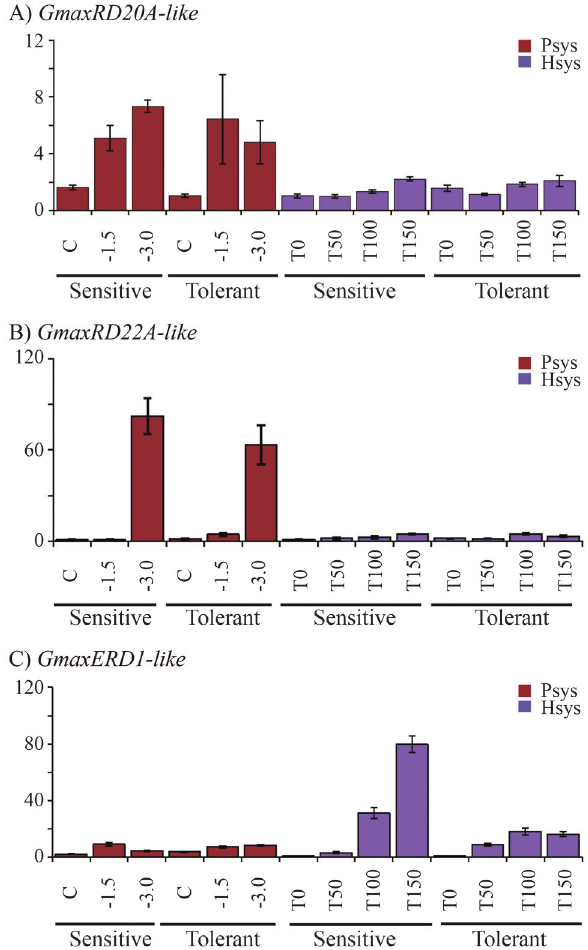
Figure 2 - Expression profile analyses for the soybean genes GmaxRD20A- like (A), GmaxRD22- like (B) and GmaxERD1- like (C) in the roots of sensitive and tolerant cultivars during water deficit stress in pot-based (PSys) and hydroponic (HSys) systems. Marker genes respon- sive to soybean genotypes are differentially regulated in roots, during wa- ter deficit stress conditions established in PSys (C – control no stress; (cid:4) w -1.5 MPa and (cid:4) w -3.0 MPa) or in HSys (T0, T50, T100; and T150 min af- ter water privation, respectively). The relative expression values, repre- sented on the Y-axis, were obtained by qPCR experiments and calculated usingthe2 Ct methodwith ACT and FBOX asendogenouscontrolgenesfor normalization. The qPCR assay for each gene was performed in triplicate for each of the two independent biological replicates used in the valida- tion. Means and Standard errors of three technical replications are shown. Thebrownandpurplebarsindicatethepot-basedandhydroponicsystems,